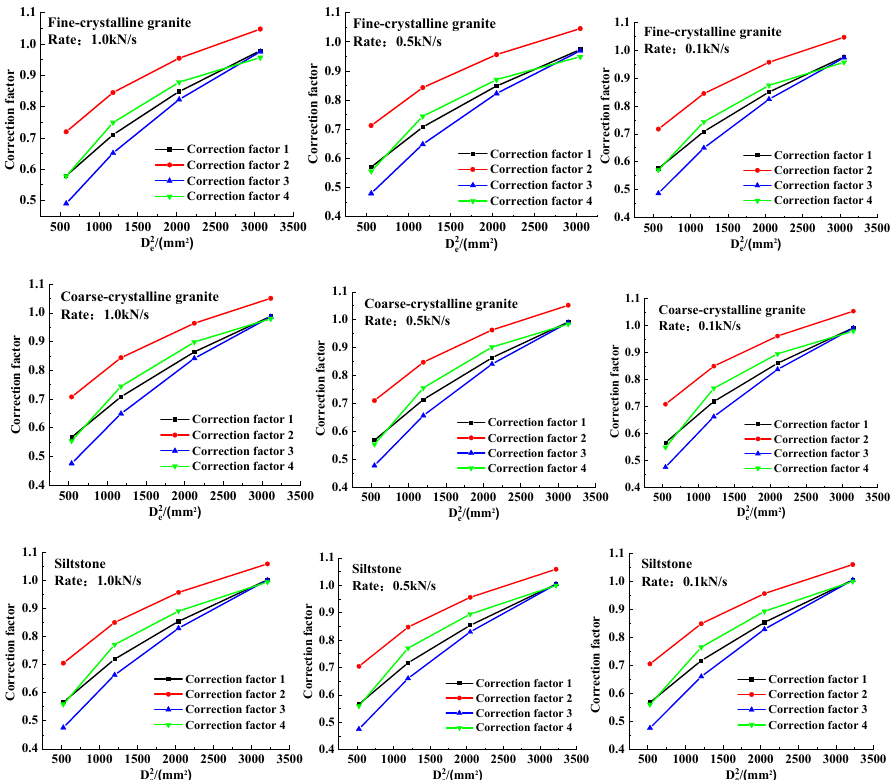
Figure 9. Three correction factors versus size for the three rock samples at different loading rates.